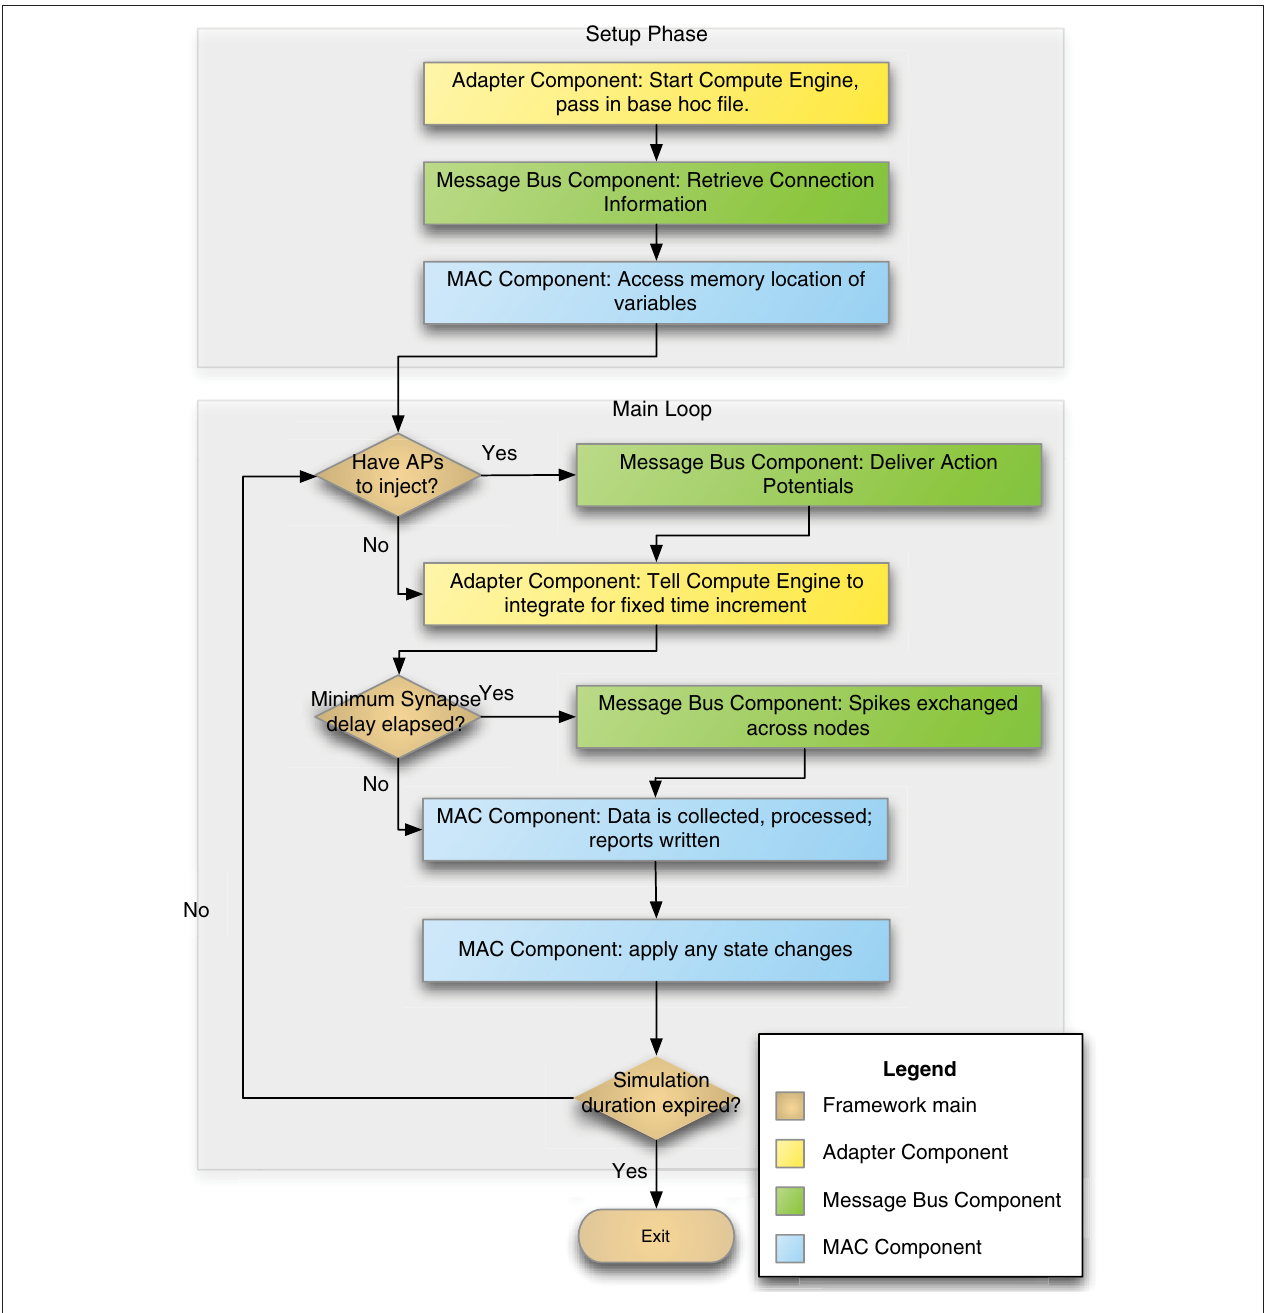
FIGURE 2 | Control fl ow in the Extension